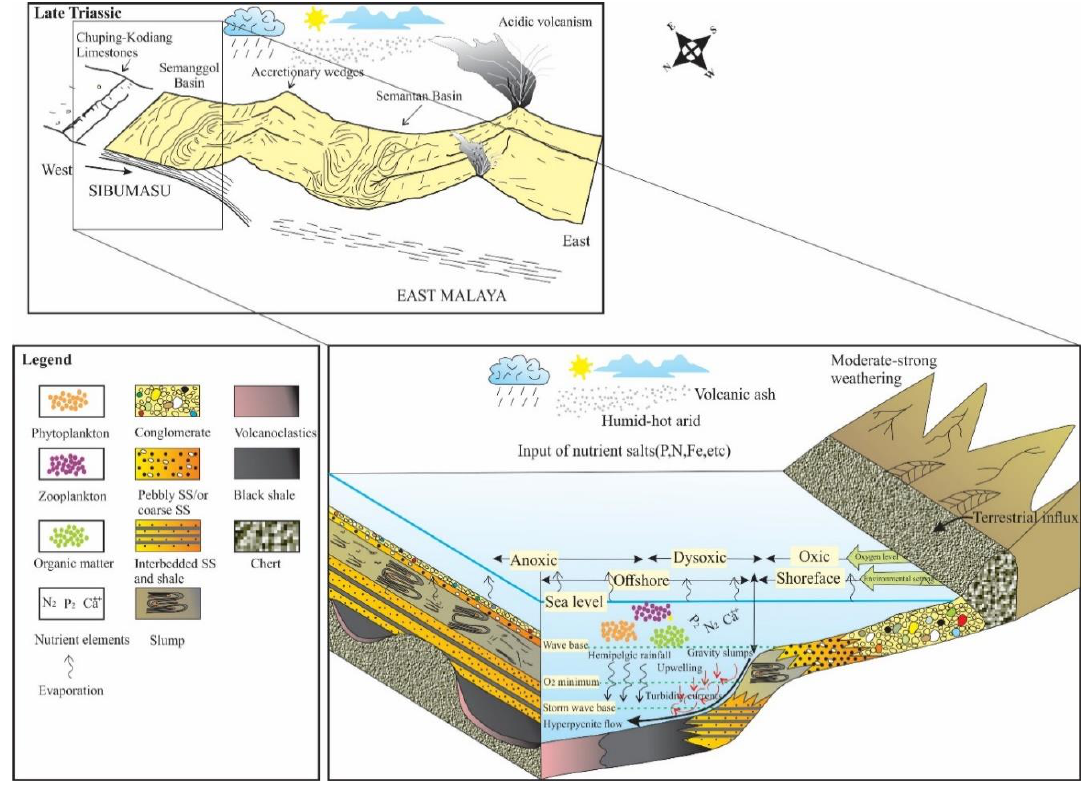
Figure 11. Block diagram illustrating the formation, accumulation, and deposition of organic matter in the Semanggol Basin during the Triassic.